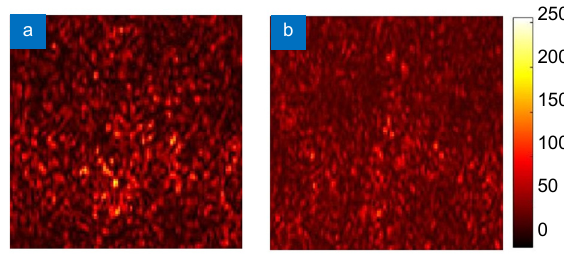
Fig. 5 | Speckle patterns (a) before and (b) after loading the designed 2-order PPA. The speckle contrast is reduced from 0.57 to 0.30, and a relative ratio γ = 52.63% is realized.